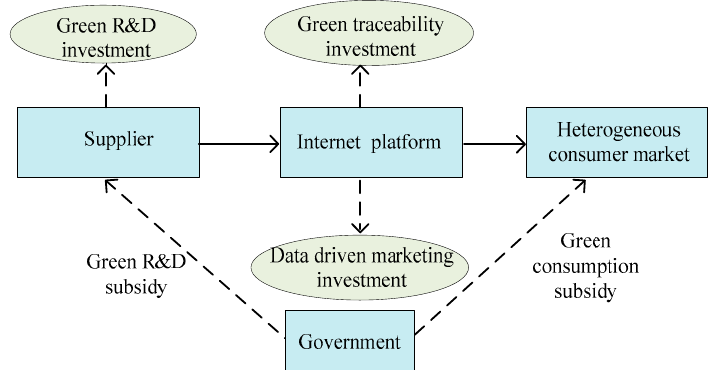
Figure 1. The structure of GAPSC with platform traceability and DDM.